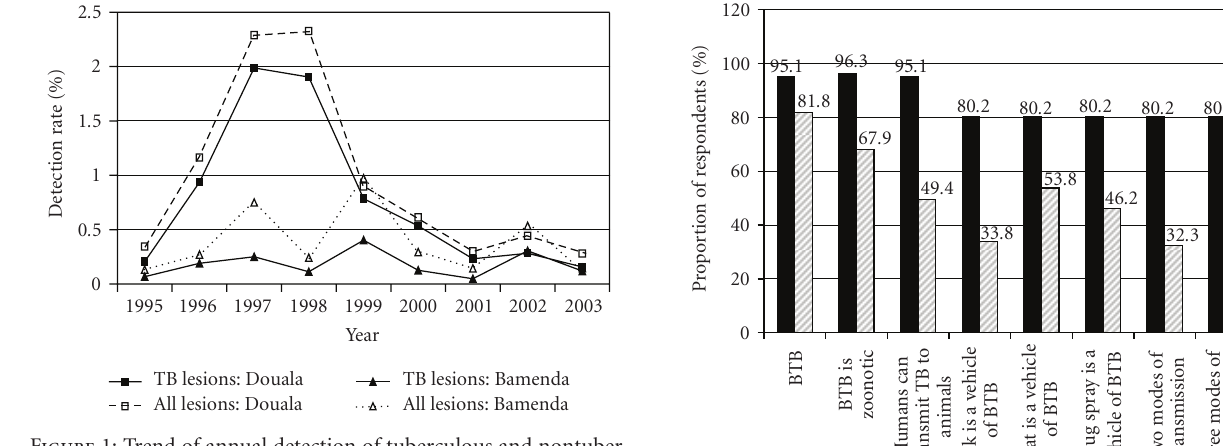
Figure 1: Trend of annual detection of tuberculous and nontuber- culous lesions in slaughtered cattle in the main abattoirs in Douala and Bamenda areas of Cameroon.